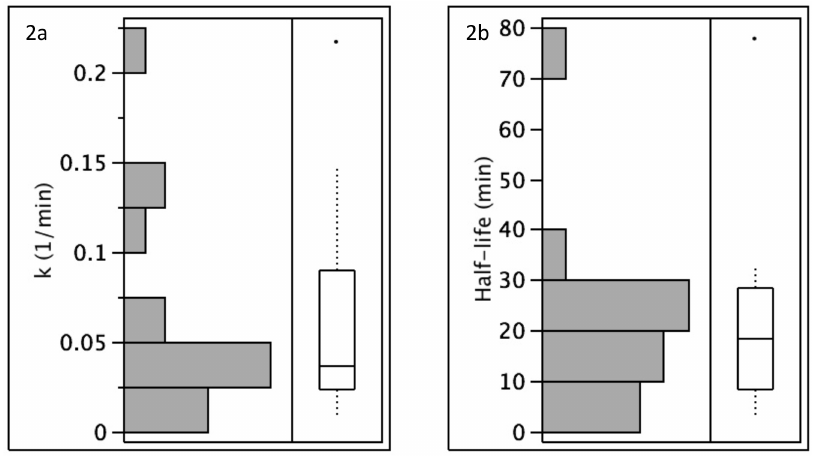
Fig 2. Distribution of rates of HCV clearanceby allografts. Viral clearancewas expressedas k (1/min) and half-life (min). Histograms (A ) and box plots (B ) demonstrate that these distributionsare skewed toward slower clearance, althoughoutliers impactedhalf-life less than